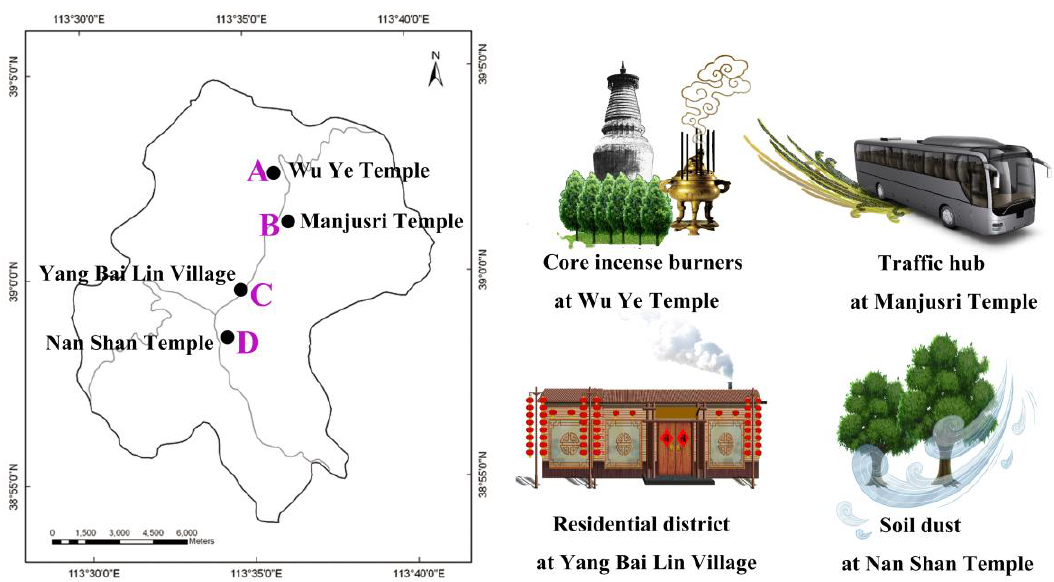
Figure 1. The distribution of the four sampling sites in Mount Wutai, Shanxi Province, China.